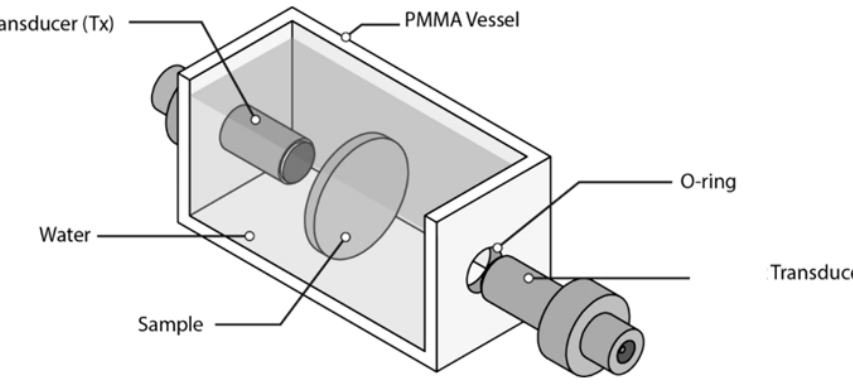
Figure 3. Experimental set-up. ( a ) Configuration for the measurement of both the transmission co- efficient and the FE film and the film response in Rx mode; ( b ) configuration for the measurement of the FE film response in Tx mode.